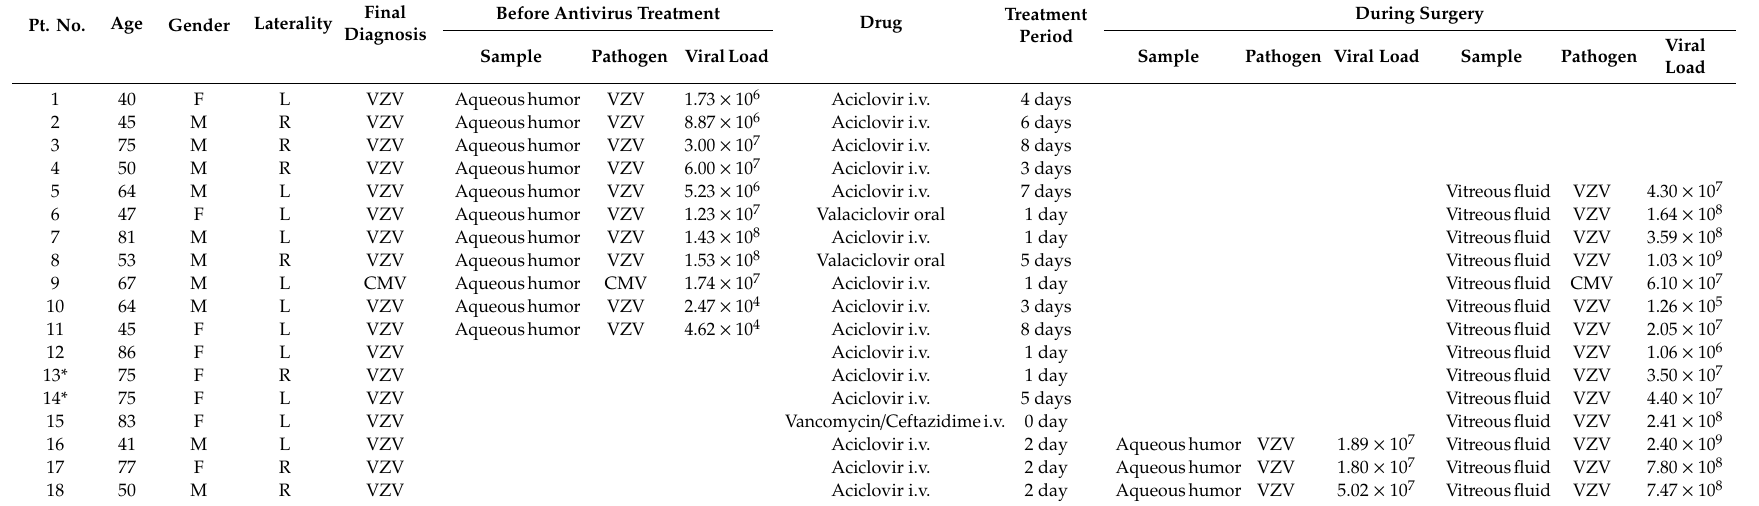
Table 1. Clinical summary of patients with suspected ARN and viral loads of ocular